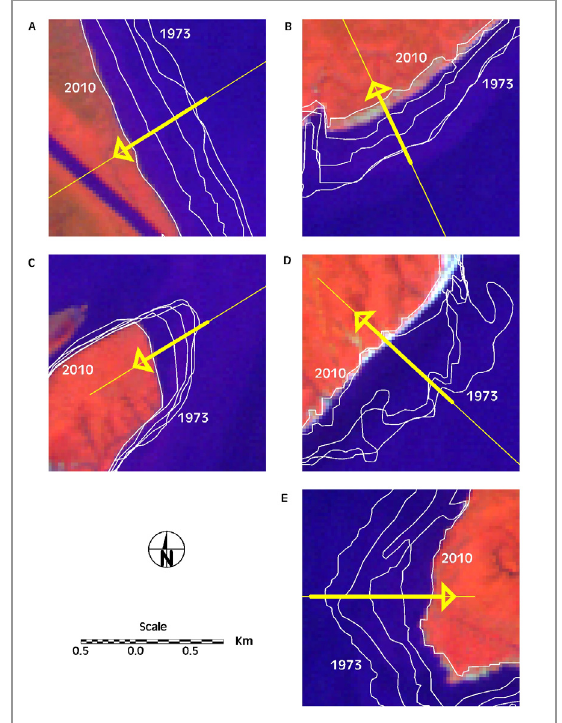
Figure 2. Demonstration of time series coastal erosion (1973-2010) in the eastern part of Sundarbans (Bangladesh part)